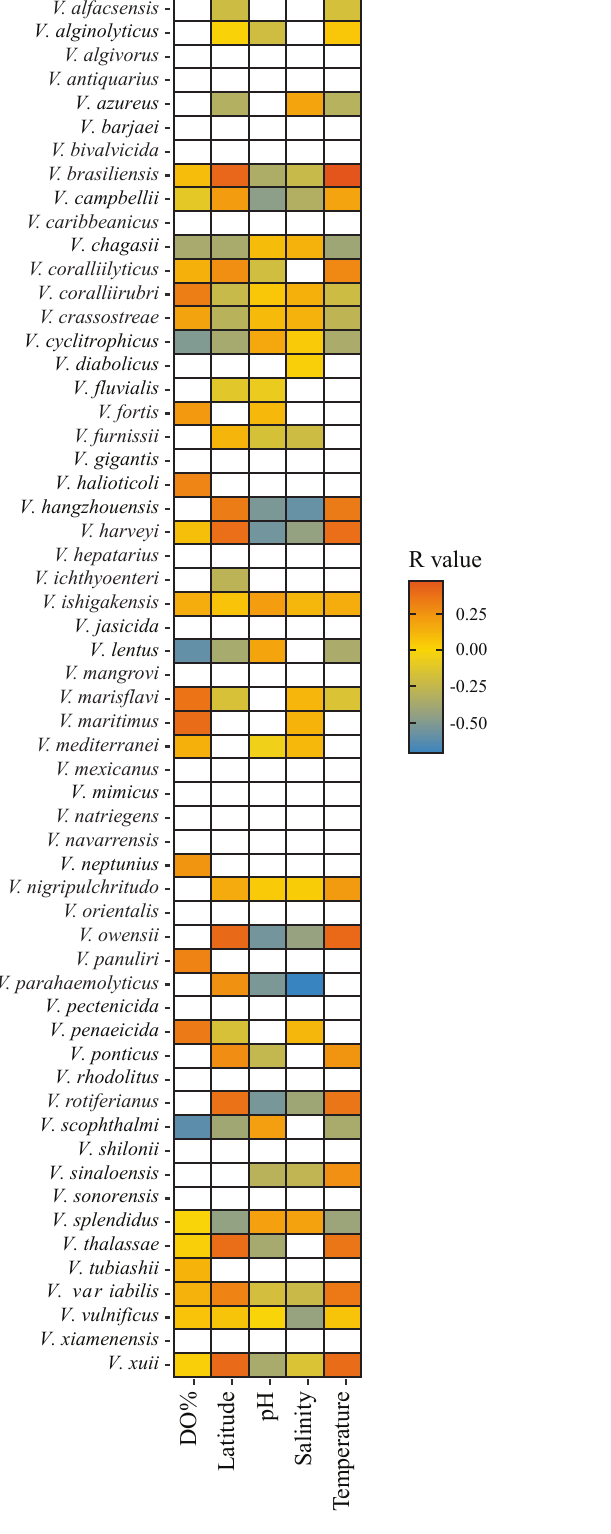
Figure 5. Heatmap displaying the correlations from MicTools analysis between environmental variables and Vibrio species from hsp60 dataset. Each cell is either coloured or white, with coloured cells representing pearsonR R value and white cells representing no significant